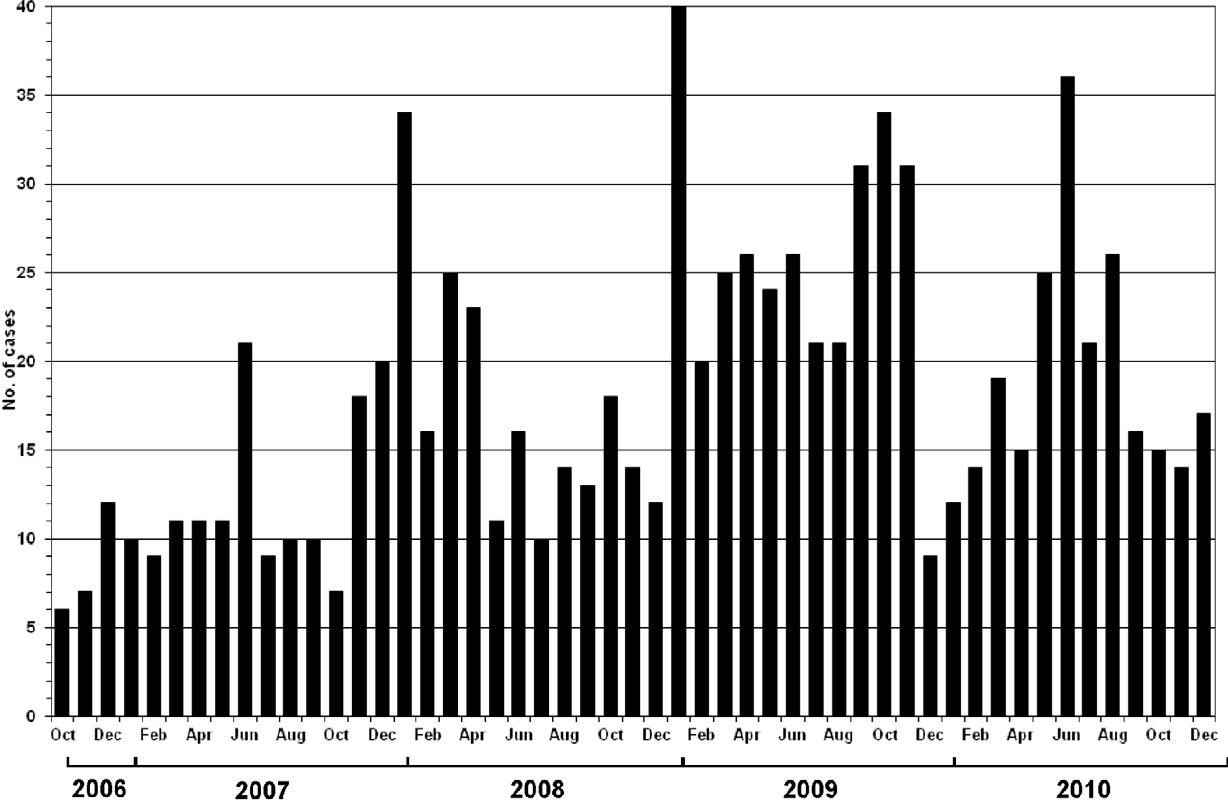
Figure 2. Influenza-like illness detected by passive surveillance in Maracay, Venezuela: October 2006–December 2010.